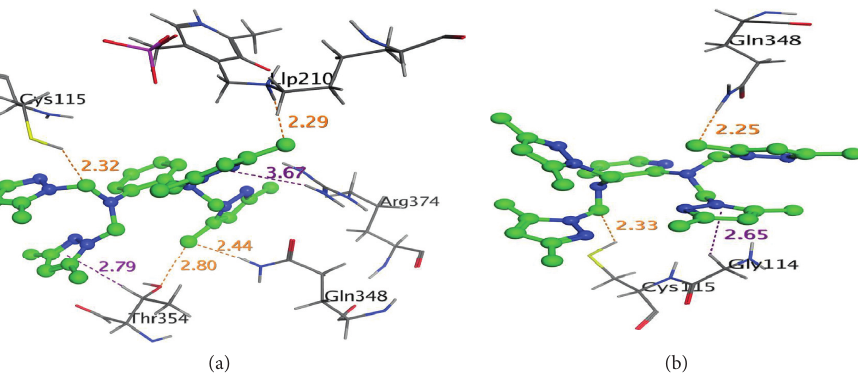
Figure 7: Interaction network of compound 12 (a) and compound 13 (b) with L-methionine c -lyase enzyme